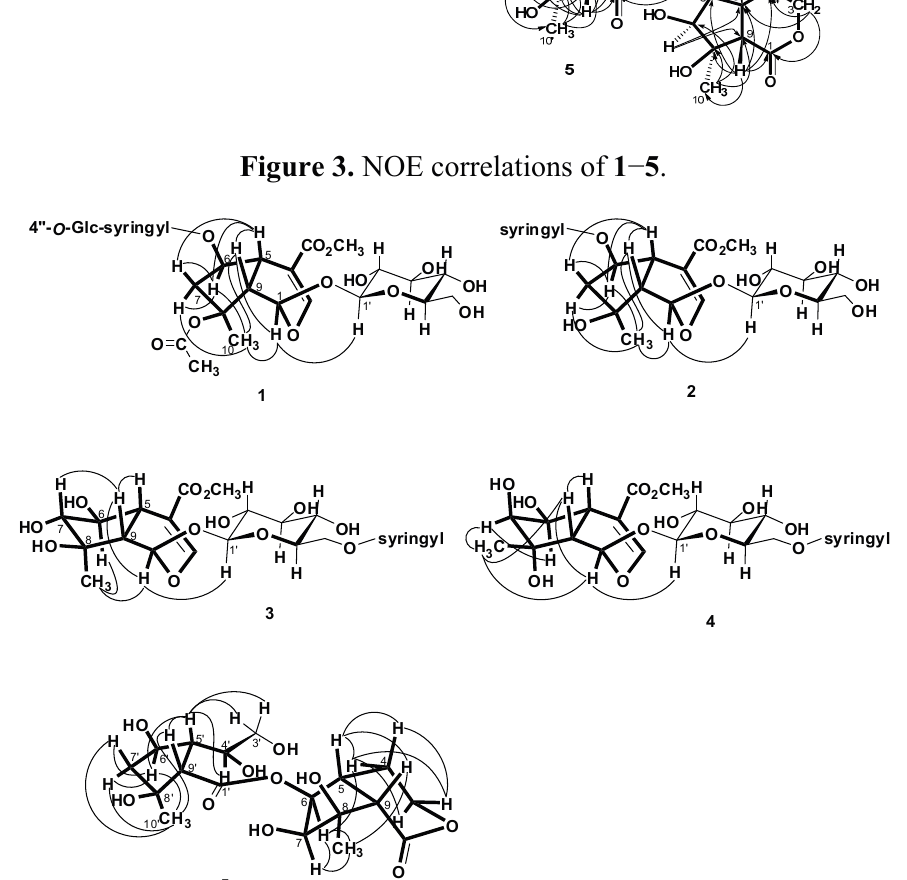
Figure 3. NOE correlations of 1 − 5